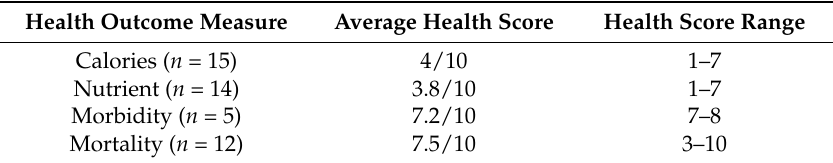
Figure 2. Aggregated health rubric scores by health outcome measure. The area of each circle denotes the number of articles represented at each rubric score (vertical axis), within the health outcome (horizontal axis). Note: As some articles included multiple measures (i.e., mortality and morbidity), their health scores are reported in all relevant categories. Table 6. Average health rubric scores by health outcome measure.